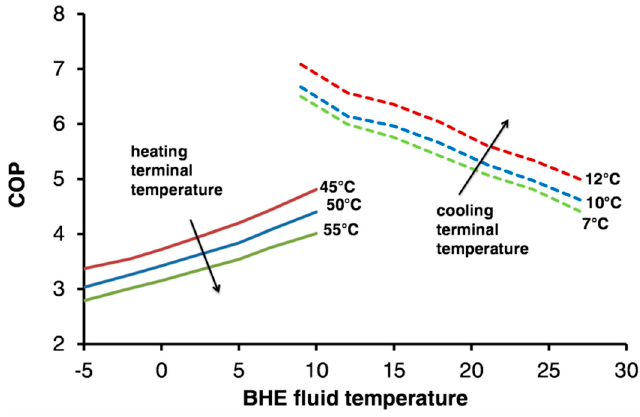
Figure 3. Heating and cooling COP map for a heat pump with a peak heating power of 10.5 kW.